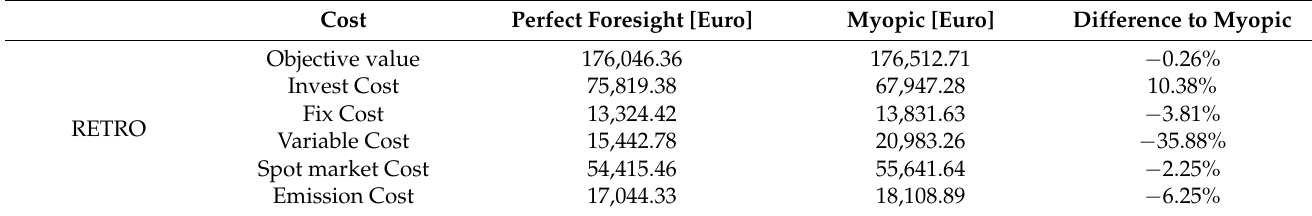
Table 10. Objective and cost values of the RETRO